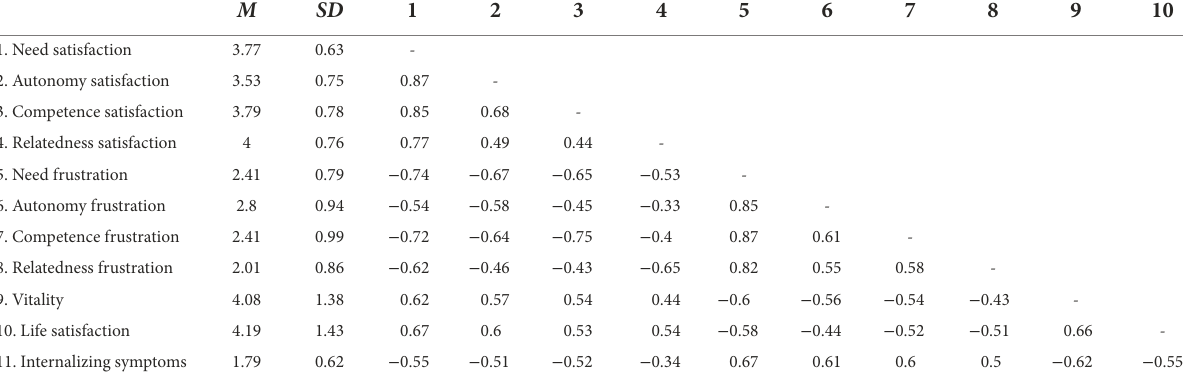
TABLE 1 Descriptives of and correlations between the study variables ( N = 326).